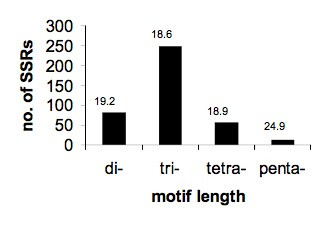
Microsatellite distribution. SSRs were sorted according to repeat motif length. The height of the bar indicates the number of SSRs that were found for each class. Numbers above bars denote average total SSR length.